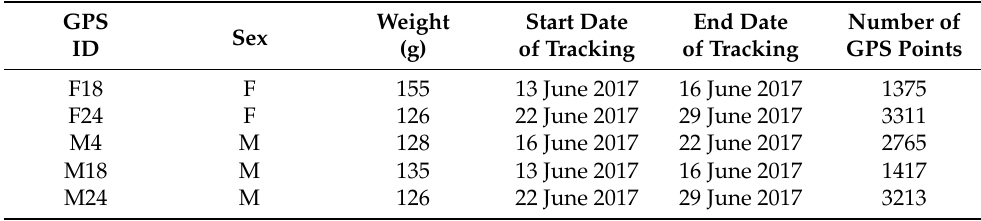
Table 1. Data of the GPS-tracked lesser